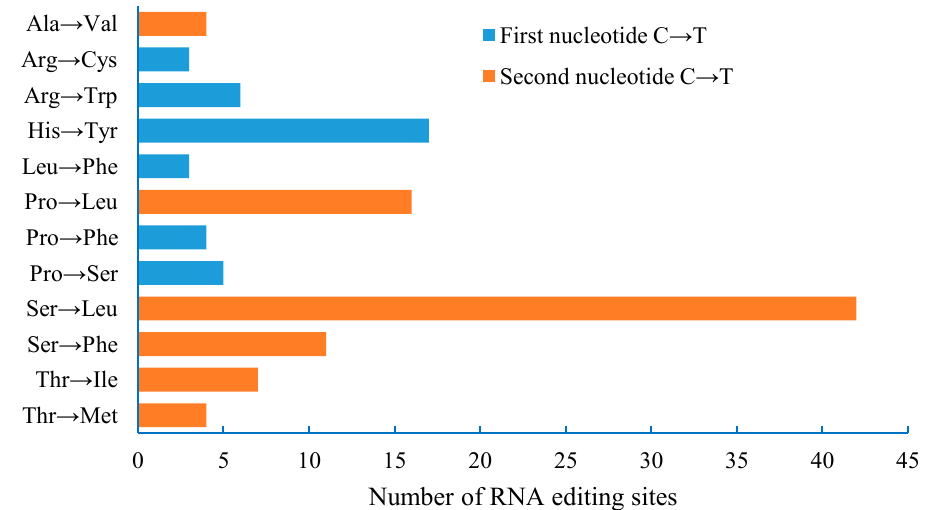
Figure 3. The prediction of RNA editing sites number and amino acid changes.